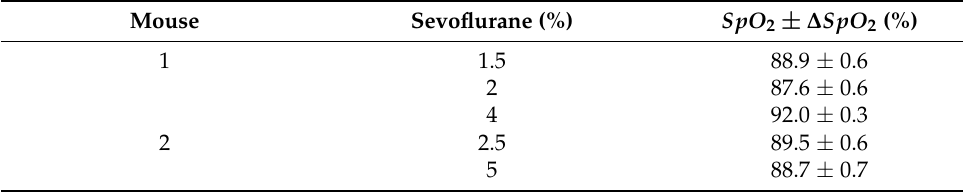
Table 3. SpO 2 values for the several concentrations of sevoflurane.